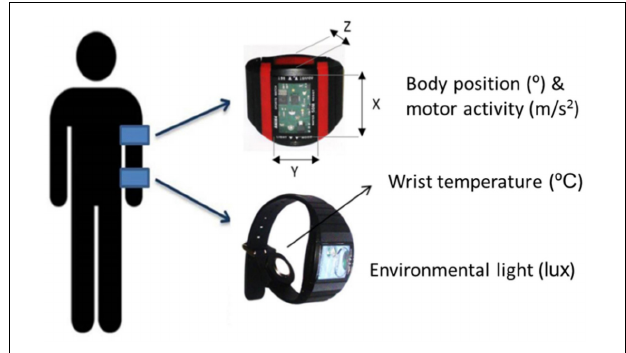
FIGURE 1 | Schematic arrangement of the ambulatory circadian monitoring device Kronowise R (cid:13) , composed of a luxometer and a temperature data logger placed on the wrist, and an accelerometer placed on the arm (Chronobiology Laboratory, University of